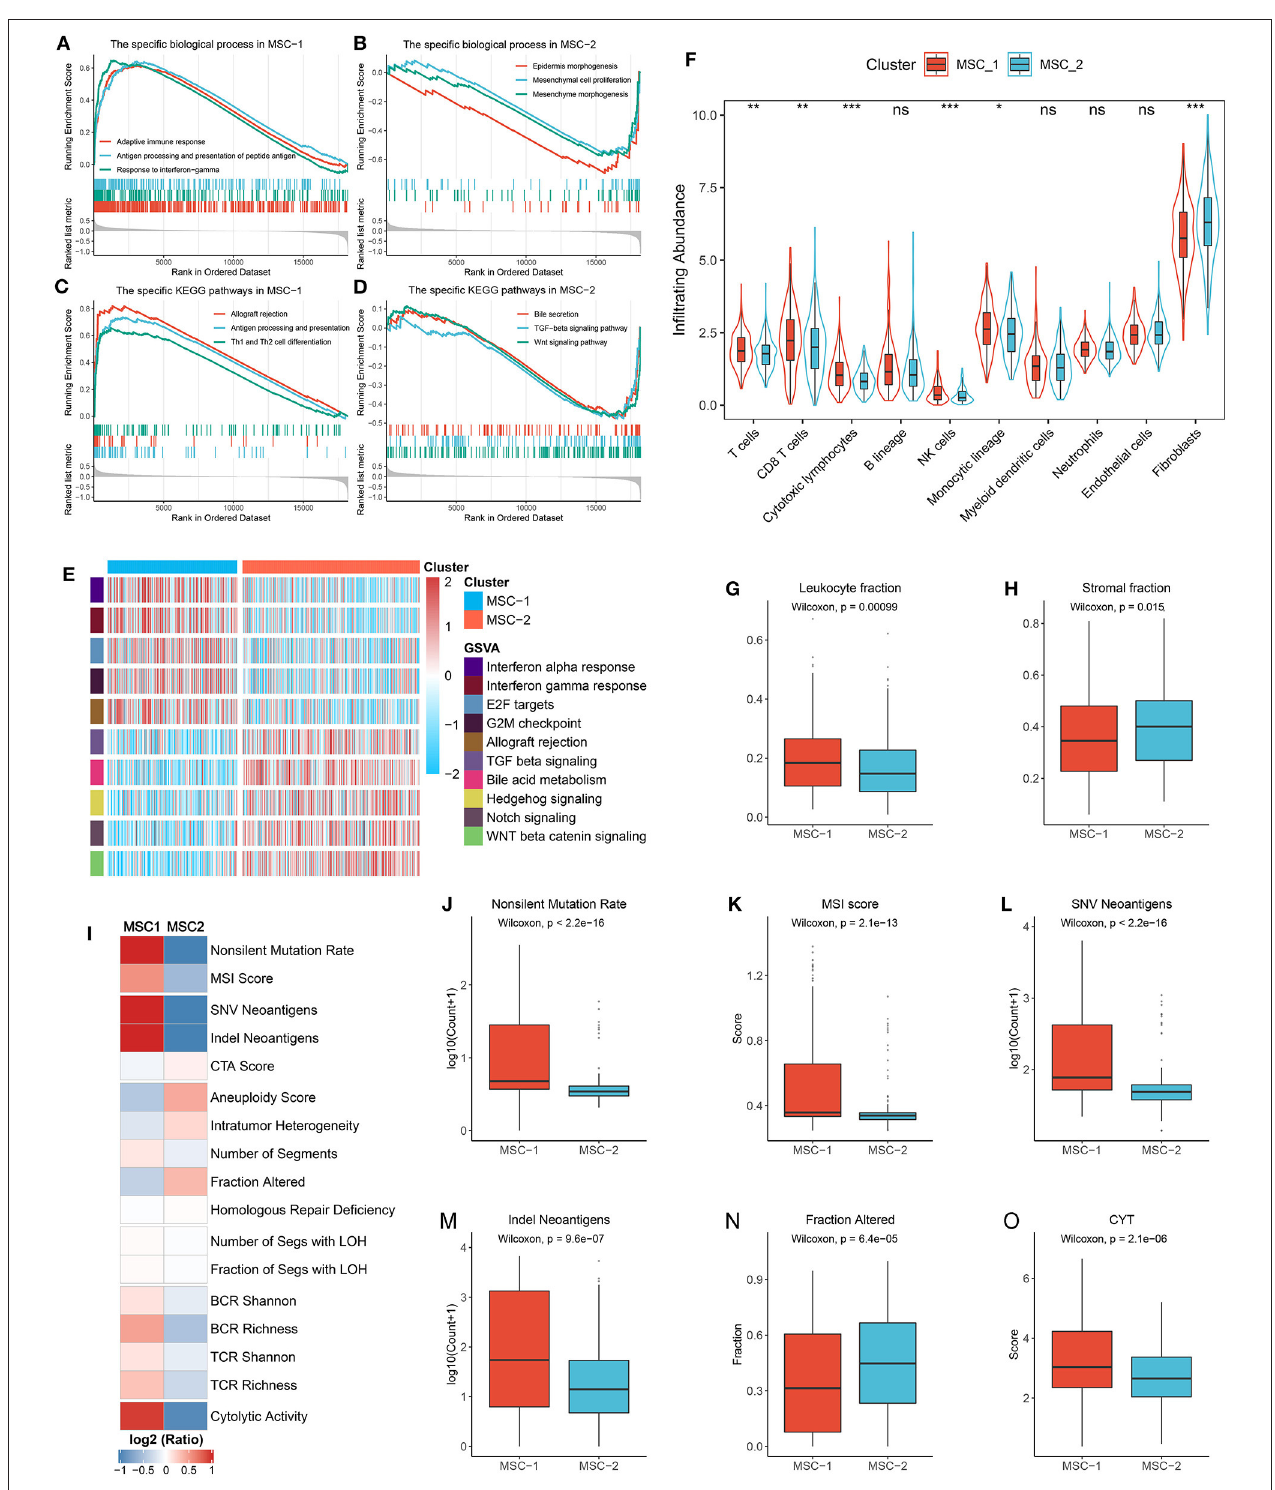
FIGURE 5 | Functional status, immune cell infiltration, and immunogenicity assessment. (A,B) The biological process significantly enriched in MSC-1 (A) and MSC-2 (B) . (C,D) The KEGG pathways significantly enriched in MSC-1 (C) and MSC-2 (D) . (E) The specific Hallmark pathways in MSC-1 and MSC-2. (F) The infiltration abundance of eight immune cells and two non-immune cells populations in MSC-1 and MSC-2. ns, P > 0.05; * P < 0.05; ** P < 0.01; *** P < 0.001. (G,H) The distribution of leukocyte (G) and stomal (H) fraction in MSC-1 and MSC-2. (I) The comparison of 17 immunogenicity associated indicators between two subtypes, the cell represented by the mean value of corresponding cluster divided by the overall mean value. (J–O) The distribution of non-silent mutation rate (J) , MSI score (K) , SNV neoantigens (L) , Indel neoantigens (M) , fraction of segments alteration (N) , and cytolytic activity (CYT) (O) in MSC-1 and MSC-2.